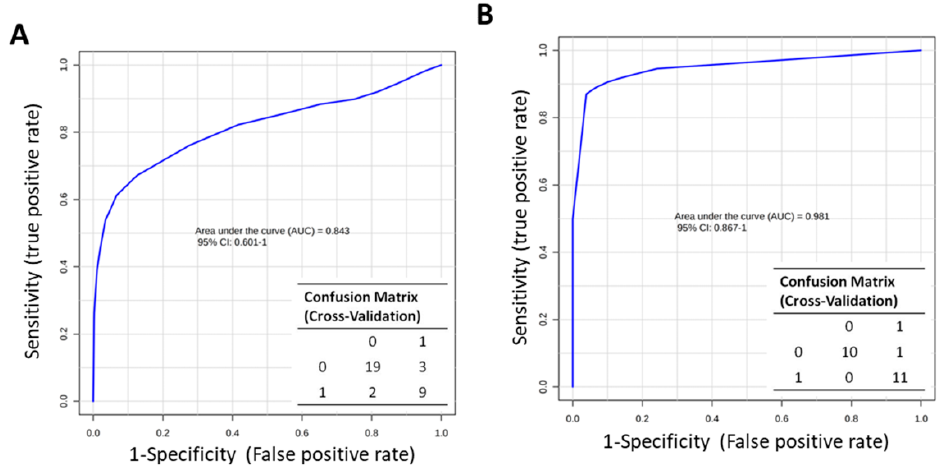
Figure 6. Potential Diagnostic power of tears and serum metabolites ( A ) Panel shows the Cumulative ROC curve based on tears significantly modulated ACs and Confusion Matrix obtained by 100-cross validation test using Metaboanalyst 3.0 software. Class0 = HCs and Class1 = MuS patients. ( B ) Panel shows the cumulative ROC curve and the confusion matrix based on serum levels of Ser, Thr, Asn, Glu, Orn, Tyr, and Arg. We used K-means (KM) clustering to detect the metabolites with similar behaviour to help reduce the redundancy in biomarkers analysis.